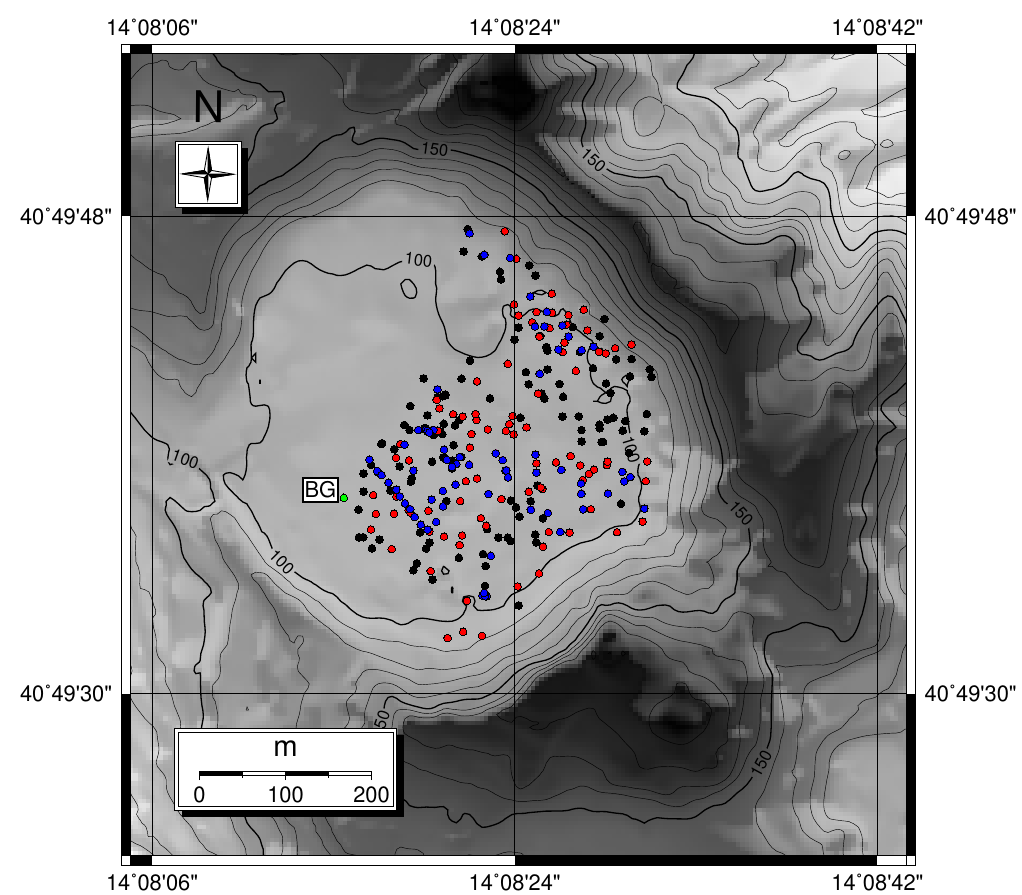
Figure 2. Map of the sampled points at La Solfatara volcano (Campi Flegrei) in the period 2011–2017. The total number of point is 352, including the background point (green point, BG): black points are the points with an inverted gradient (Figure 3c), red points are those with a direct one (Figure 3a,b,d), among which we selected those only acquired during night (blue points), see also Section 3.1.2. The northwestern part of the crater surface has not been sampled as it is highly vegetated.